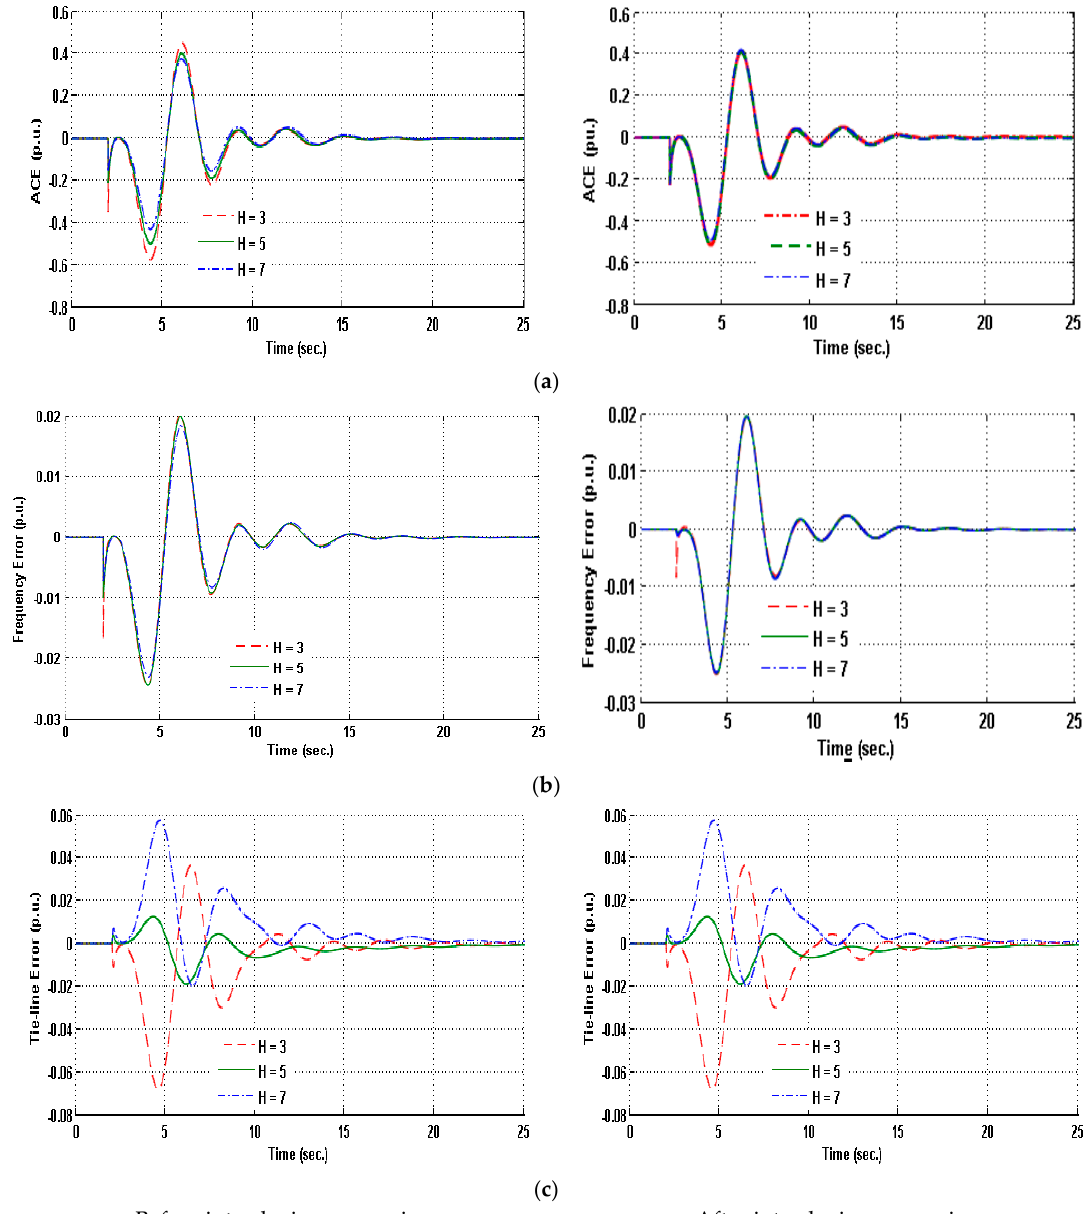
Figure 11. Effect of H -parameter on: ( a ) ACE, ( b ) frequency error, and ( c ) tie-line error before and after introducing an extra gain block.